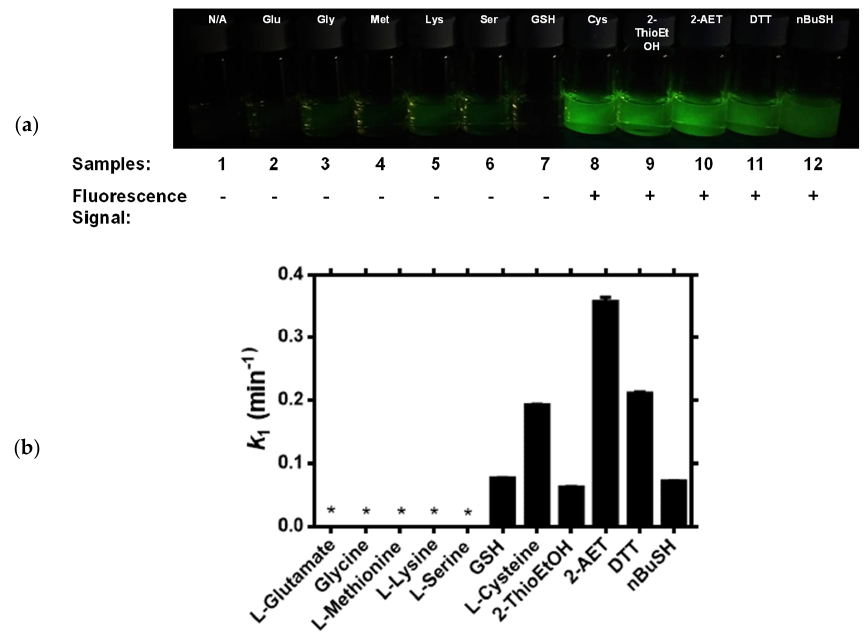
Figure 2. Differential reactivity of 16b toward reactants as revealed by direct visualization and kinetic analysis. ( a ) Visualization of the 6-FAM fluorescence to characterize the fluorescent emis- sion properties of 16b in the presence of various reactants. Each vial contained 25 μ M of 16b in the Tris buffer (50 mM Tris, 1 mM Ca 2+ , pH 8.0). In addition, samples 2–12 also included the reactants (50 mM) of L-glutamate, glycine, L-methionine, L-lysine, L-serine, glutathione (GSH), L-cysteine, 2- mercaptoethanol (2-ThioEtOH), 2-aminoethanethiol (2-AET), DL-dithiothreitol (DTT) and 1-bu- tanethiol (nBuSH), respectively. The reactions were carried out in the dark at rt for 1.5 h before the photograph was taken under UV illumination (365 nm). ( b ) Determination of the pseudo-first order rate constant k 1 from each of the reactions of 16b with various reactants. Please see Section 3.3 for the experimental details. Each reactant was analyzed at least three times in order to acquire the averaged k 1 values and standard deviation (the error bar). The error bars were too short to be visible in some reactions. The symbol * indicates that 16b had no measurable reactivity, meaning that the values of averaged k 1 and standard deviation could not be determined.